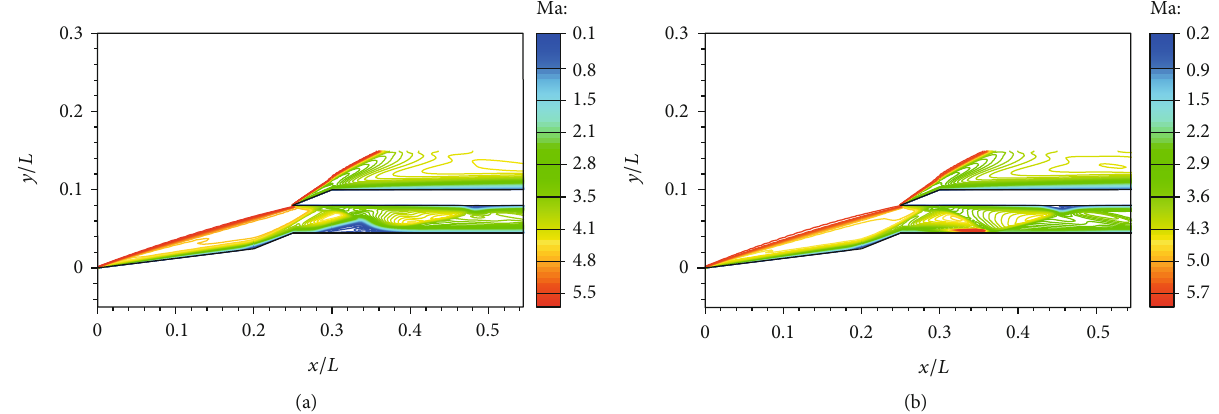
Figure 22: Mach contours in a 2D double wedge ramp hypersonic inlet: (a) fl ow fi eld without MHD control; (b) fl ow fi eld with MHD control.